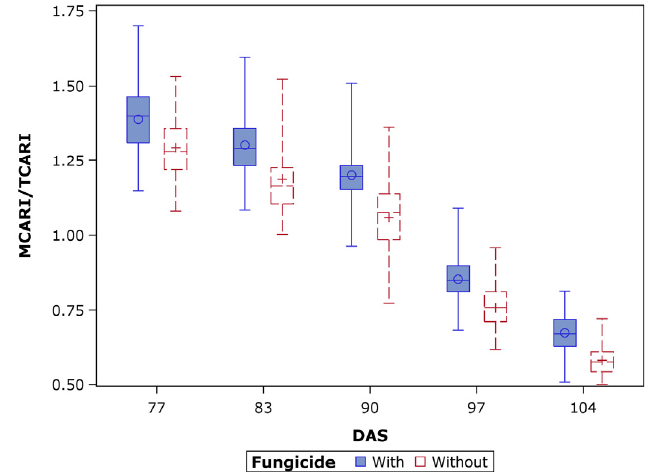
Figure 4. Box-and-whiskers plots showing the significant performance of MCARI/TCARI on discriminating between the with- and without-fungicide treatments. Significant ( p < 0.01) differences between the with- and without-fungicide treatments were observed on each sampling date across all varieties (circle and plus signs show the means of the with- and without-fungicide treatments,